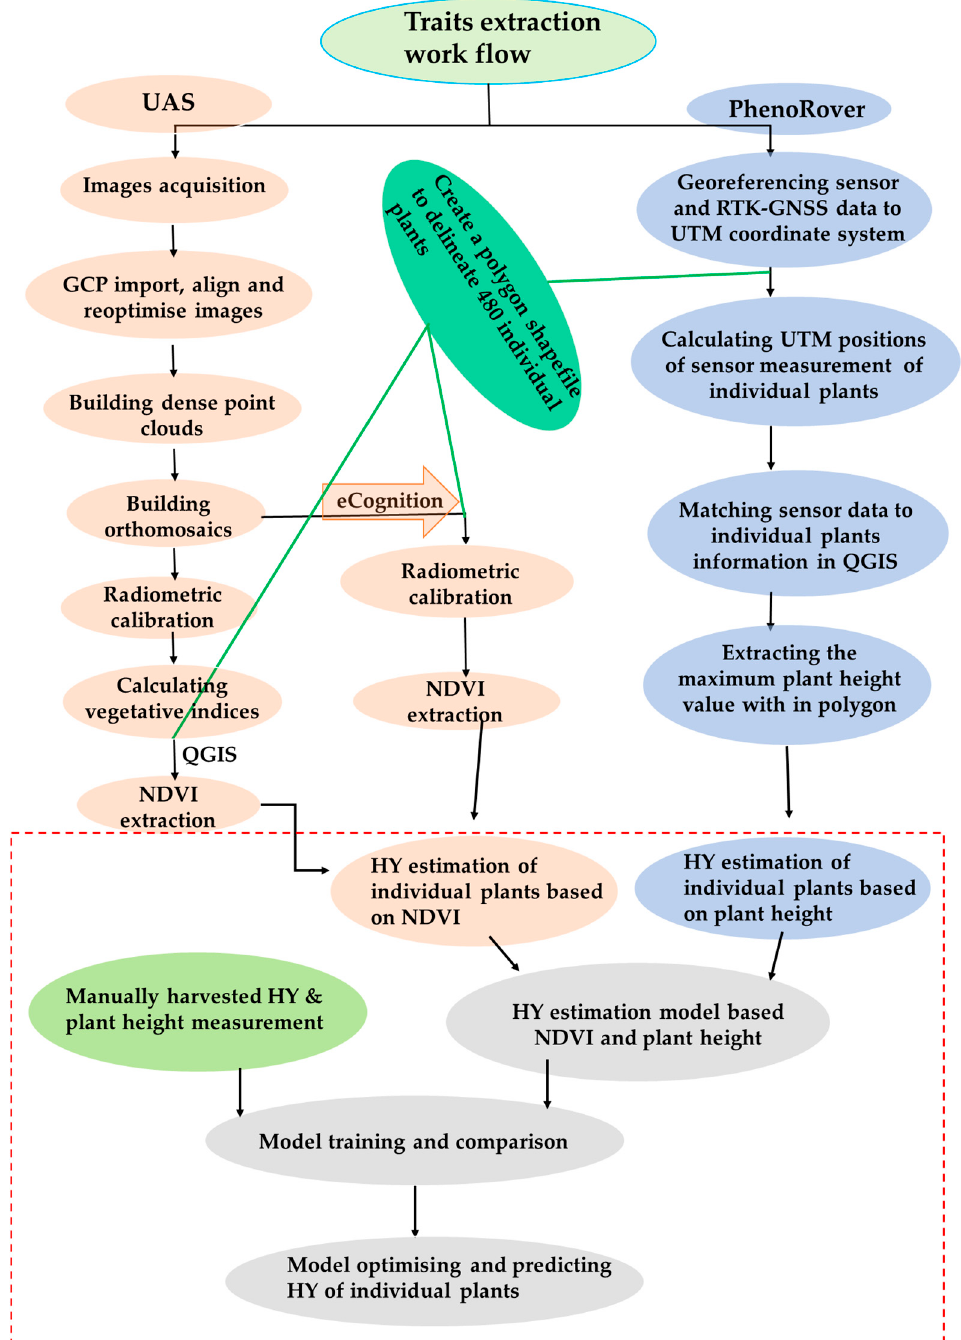
Figure 3. Workflow diagram of image processing and plant height extraction used in the GSS field trial. The steps in the left contain all procedures applied to extract single plants NDVI from the UAS images, whereas the steps in the right show the procedures followed to extract single plants plant height from the PhenoRover system. The box with the broken red line contains the methods and analysis procedures used to model the HY estimation.